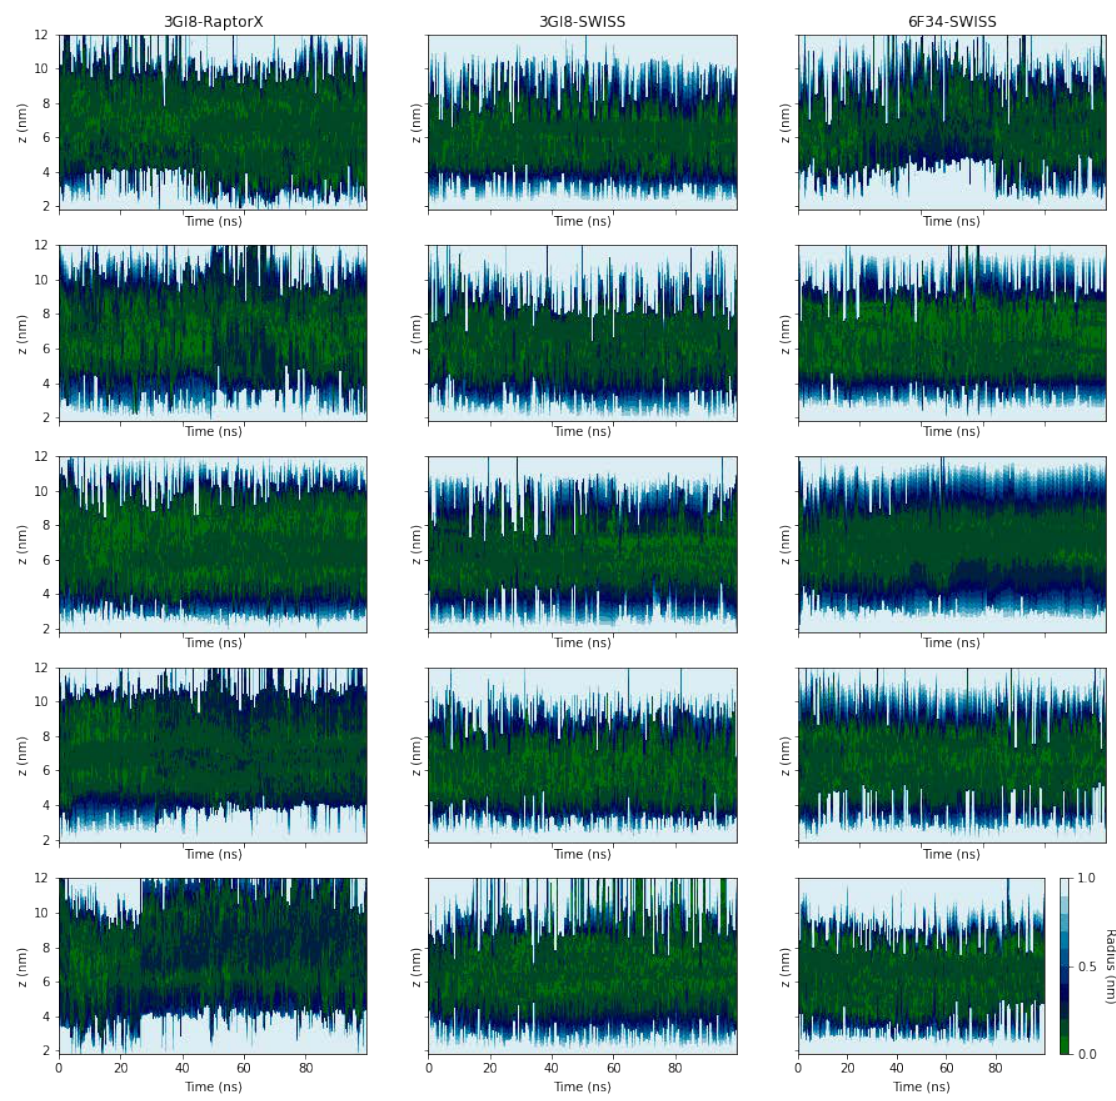
Figure A3. Width of GerAB channel as function of the time. This graphs shows for each run of the three models the radius of the channel in the z -axis (in nm) over time in ns. The z -axis is perpendicular to the membrane. The size of the pore is shown on a scale from 0 to 1 nm in color ranging from green to light blue, as indicated by the color bar. Data obtained using HOLE